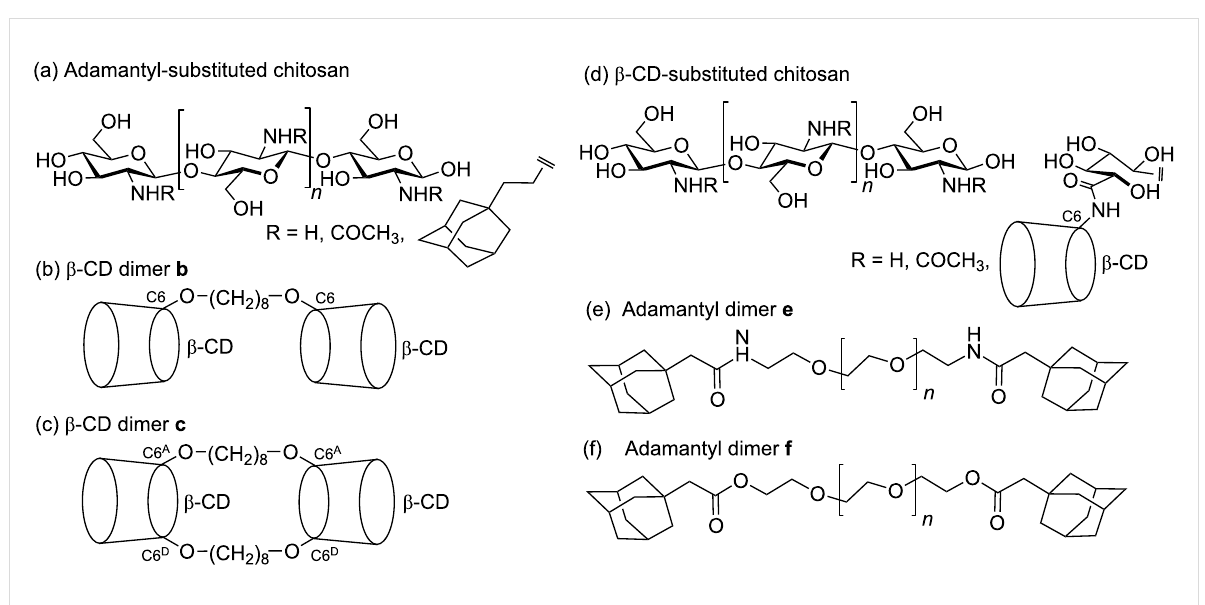
Figure 10: (a) Substituted chitosan in which acyl- and adamantyl-substitution is 5% and 12 %, respectively. (b) Octylmethylene-linked β -CD dimer b where substitution is at C6 for each β -CD. (c) Octymethylene-linked β -CD dimer c where substitution is at C6 A and C6 D for each β -CD [78] (d) Substi- tuted chitosan in which acyl- and β -CD-substitution is 12% and 10%, respectively. (e) Diaminopolyethyleneglycol-linked adamantyl dimer e . (f) Poly- ethyleneglycol-linked adamantyl dimer f [81].